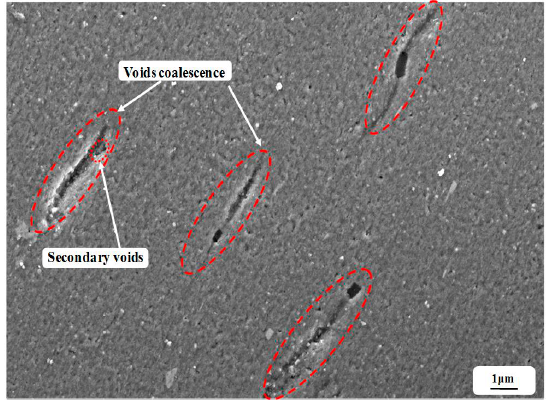
Figure 6. The microvoids interconnection of 5052-O aluminum alloy during the fracture stage.